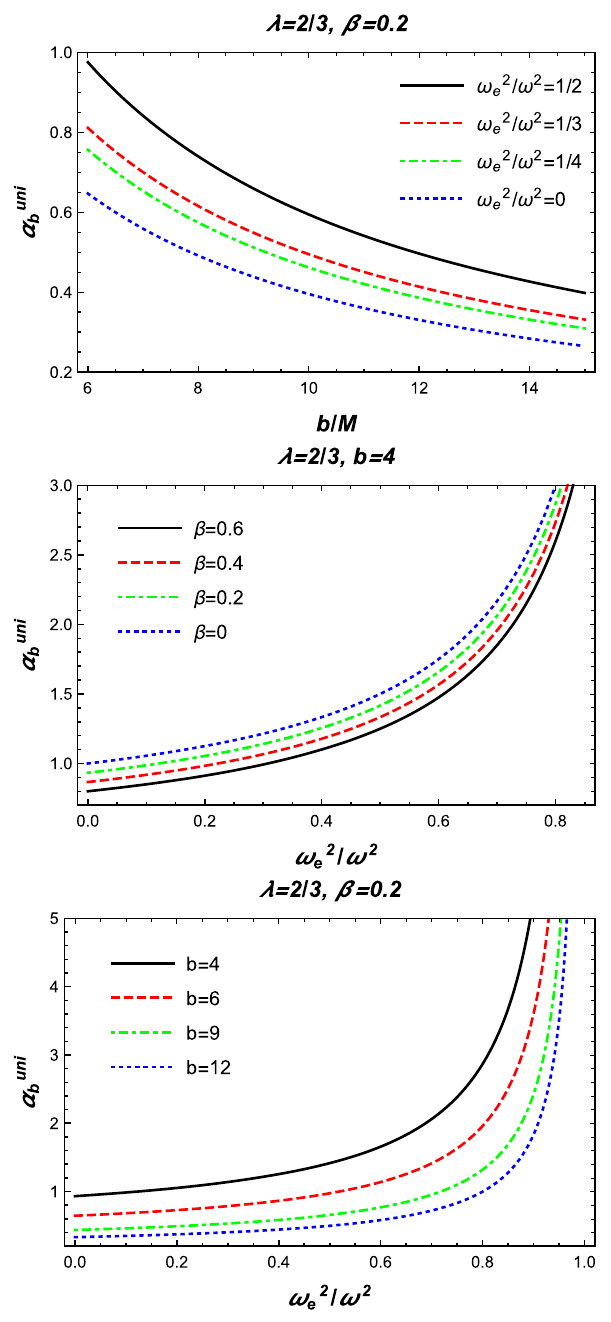
Fig. 14 α b for different value ω 2 e /ω 2 ,β and b in the uniform plasma, λ = 2 / 3 case